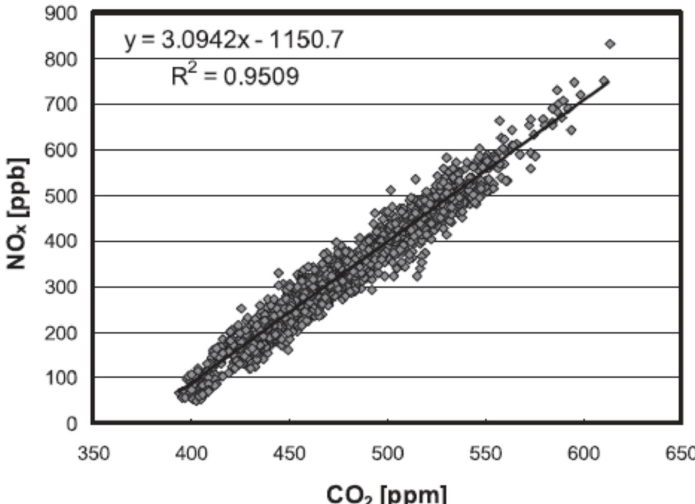
Figure 55. Plot of NO x against CO 2 data (10-min averages) at Site 2 during the third campaign. Reproduced with permission from Gallus et al. [14]. Copyright 2014 by Elsevier Ltd. (License No.: Table 9. Average NO x /CO 2 ratios obtained from experimental results in the photocatalytic remediation of NO x in the Leopold II tunnel in Brussels; standard errors represent 2 σ **.